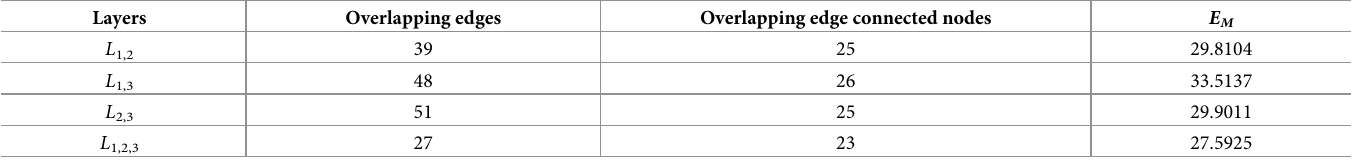
Table 6. Structure entropy of overlapping links between layers of 7thGraders multiplex network. Layers